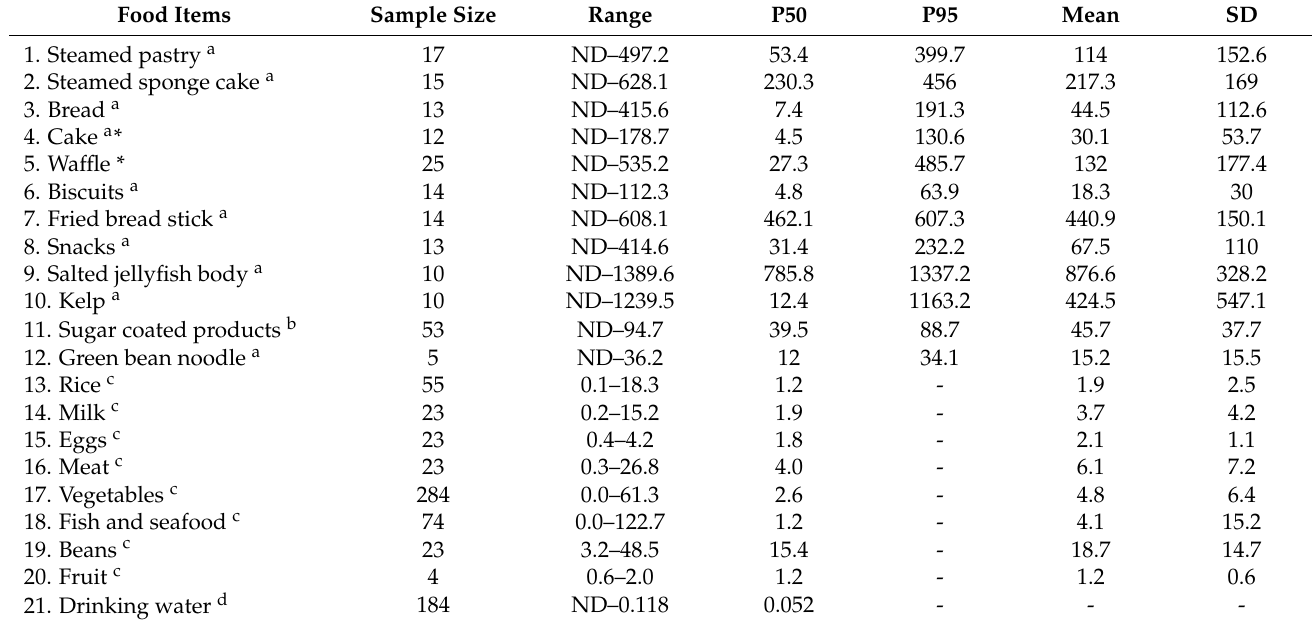
Table 1. Descriptive statistics for aluminum concentrations (mg/kg) of 12 aluminum-rich food items in Taiwan (adopted from Zhou [25] and Yeh et al. [26] and the aluminum concentrations (mg/kg) in nine additional food consumption items (adopted from Jiang et al. [21] and Yang et al. [27]. P 50 and P 95 indicate the 50th-percentile and 95th-percentile,